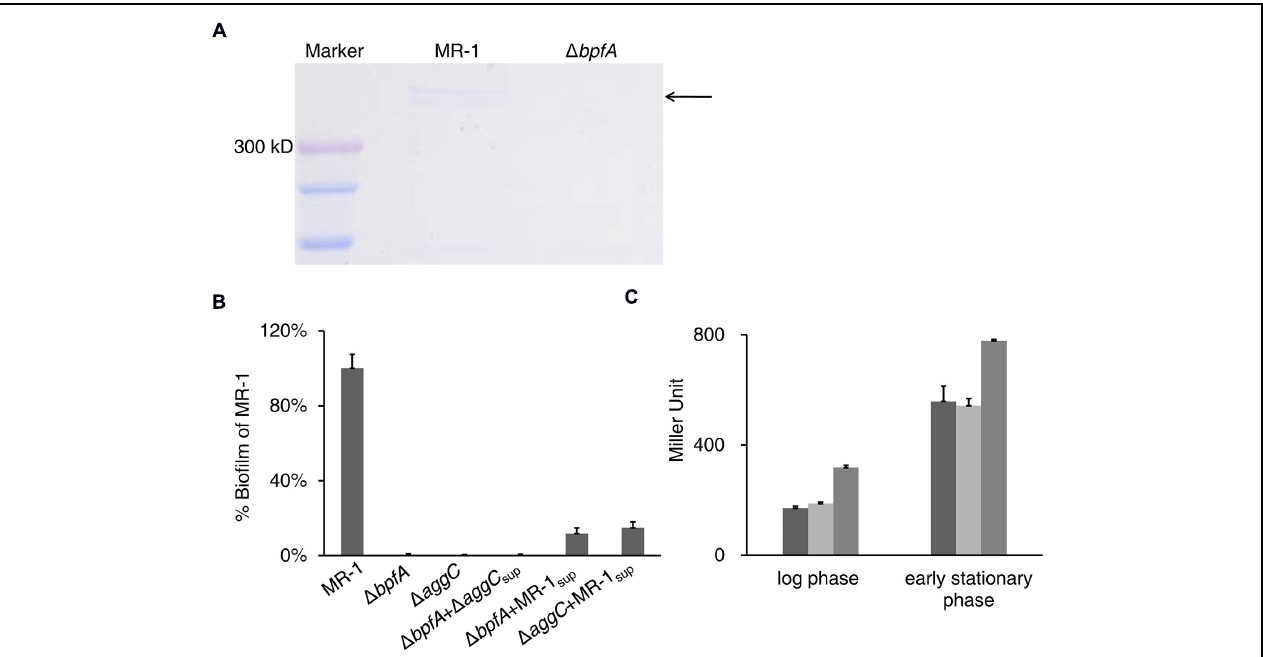
FIGURE 2 | BpfA is an extracellular adhesin required for biofilm formation. (A) BpfA from culture supernatants of the indicated strains visualized by SDS-PAGE. Arrow indicates the band corresponding to BpfA protein. (B) Culture supernatant of wild-type could partially rescue the biofilm defect of (cid:2) bpfA and (cid:2) aggC . Supernatant prepared from wild-type or (cid:2) aggC cells were added to the wells in a polystyrene